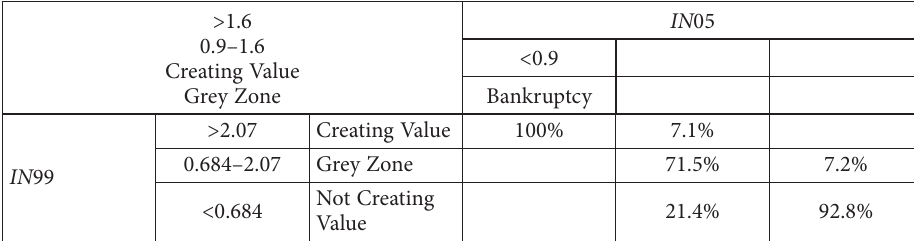
Table 9. Comparison of IN 99 and IN 05 (source: authors based on financial